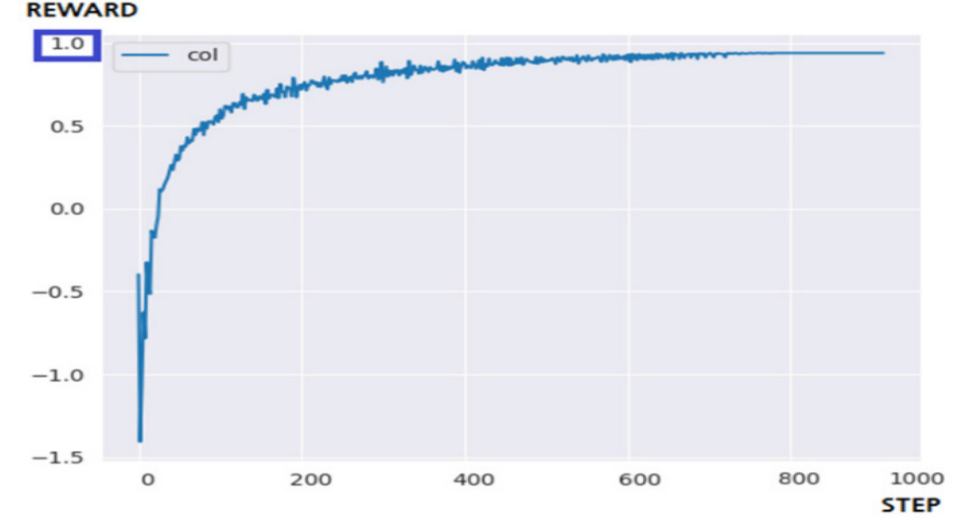
Figure 12. The result of a 10 × 10 maze game through DQN.